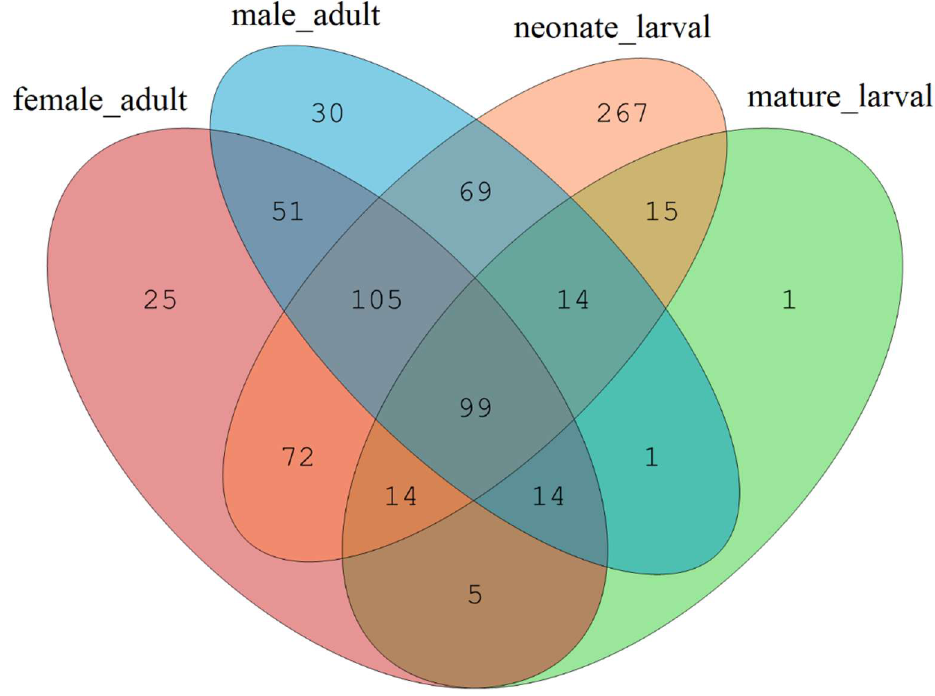
Figure 2. Venn diagram representing the distribution of the fungal OTUs in different development stages of T. klimeschi .